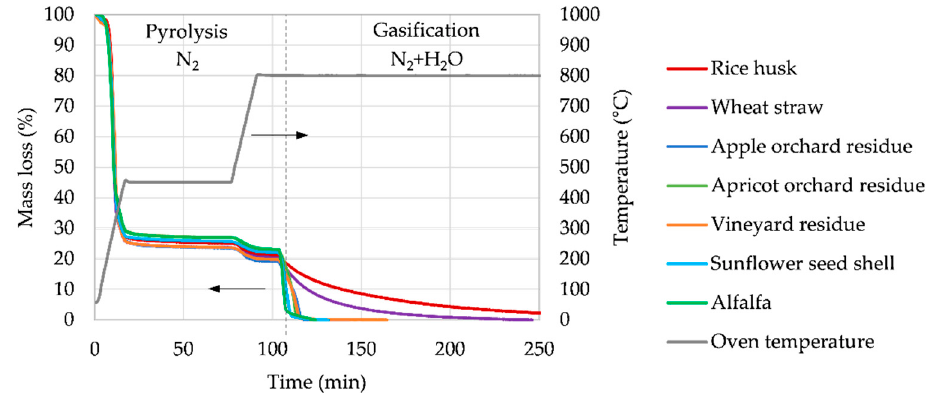
Figure 5. TGA of biomass samples presented as a mass loss and as a function of time. Pyrolysis: 0.05 L·min − 1 N 2 , 24 °C/minutes, 1 h hold at 450 °C, 15-min hold at 800 °C. Gasification: 0.05 L·min − 1 mixture 80 vol % N 2 /20 vol % H 2 O, 800 °C.